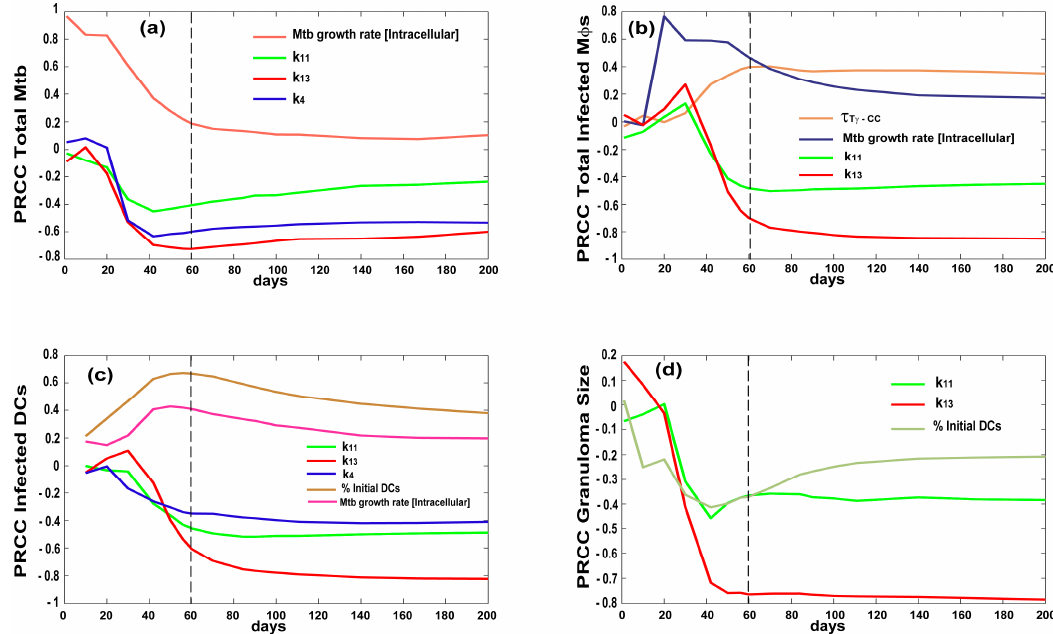
Figure 5. Time courses for Partial Ranked Correlation Coefficient (PRCC) of mechanisms/parameters affecting infection outcomes as they relate to Table 2. Each curve plotted is days post infection (up to 200 days) on the x -axis and PRCC values on the y -axis (that vary between − 1 and 1). The PRCCs plotted are only ones that were significant (i.e., p < 10 − 3 ) and with an absolute value greater than 0.3. Outcomes shown are ( a ) total Mtb, ( b ) total infected macrophages, ( c ) total infected dendritic cells and ( d ) granuloma size. Compare with Table 2 results. Parameter definitions: k 4 [CD4+T cell precursor proliferation in the LN], k 13 [CD8+T cell precursor proliferation in the LN], τ T γ− CC : chemokine threshold for T γ cells recruitment to the lung, τ Treg − TNF : TNF threshold for Treg cells recruitment to the lung, k 11 : Naïve CD8 priming (see Appendix A for details on the parameters).